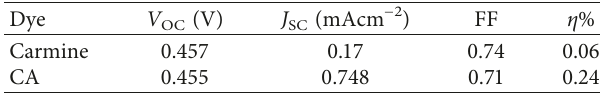
2 layer. Table 2: Experimental parameters for CA and carmine